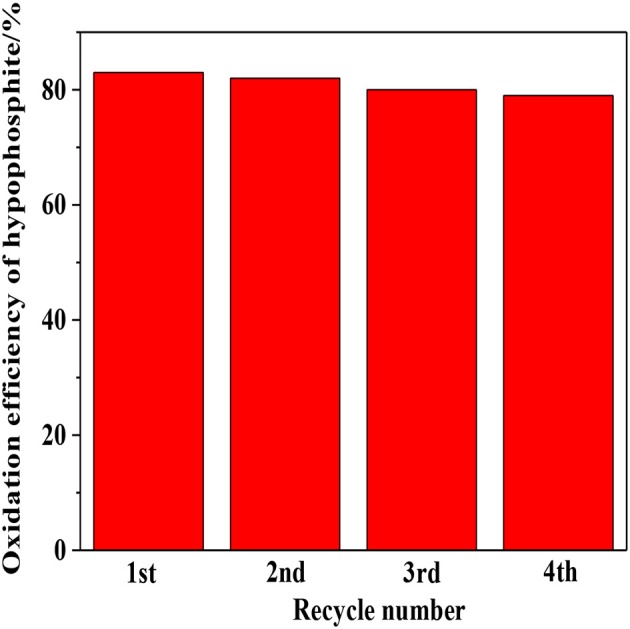
The stability analysis of the 1:2-Ti4O7/g-C3N4 photocatalyst.